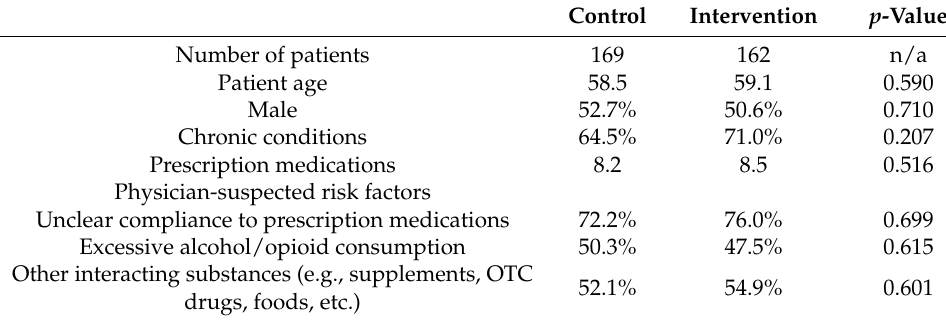
Table 2. Patient characteristics.